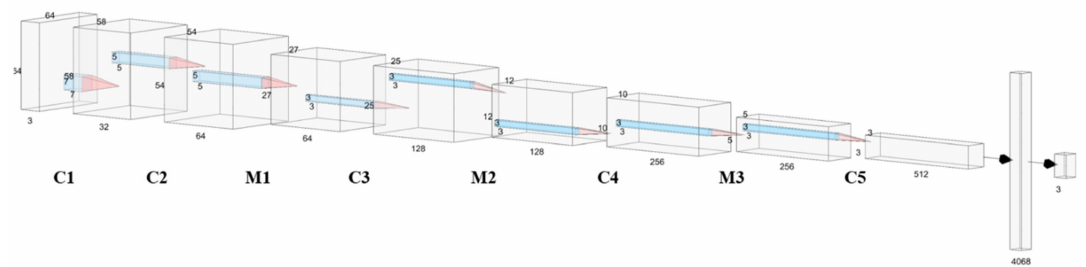
Figure 7. RadRGB architecture that involves the input images of 64 × 64, a detailed configuration of five convolutional layers, three max-pooling layers, and three output classes (C indicates the convolutional layer and M represents the max-pooling layer).